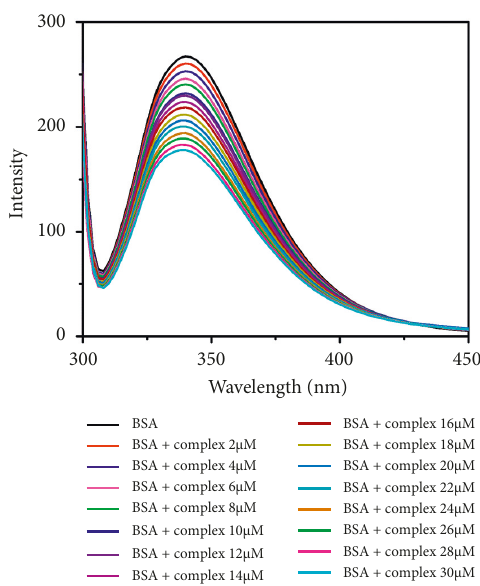
Figure 12: Fluorescence spectra of BSA (2 μ M) with complex 2 (0–30 μ M) in PBS buffer (pH